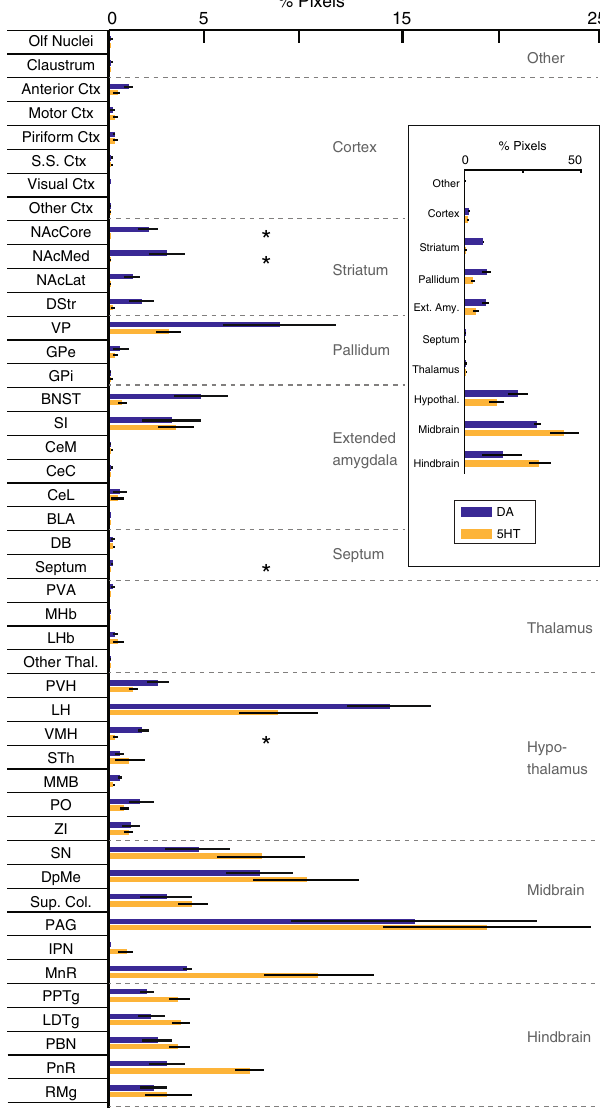
Fig. 5 Differences in monosynaptic inputs onto DA and 5HT DR